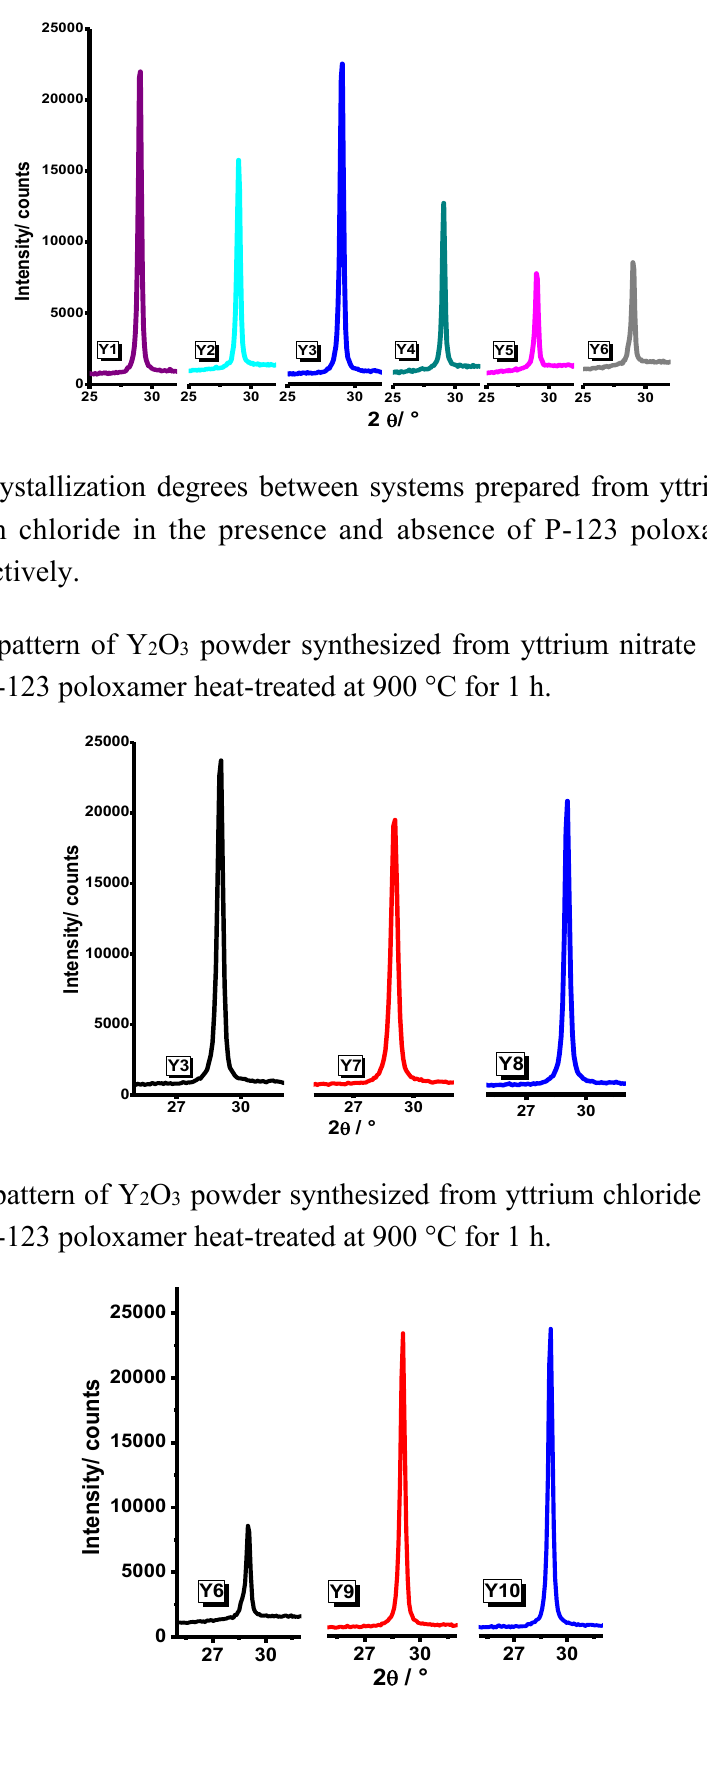
Figure 3. XRD patterns of Y 2 O 3 systems prepared from yttrium nitrate and yttrium chloride at different temperatures.